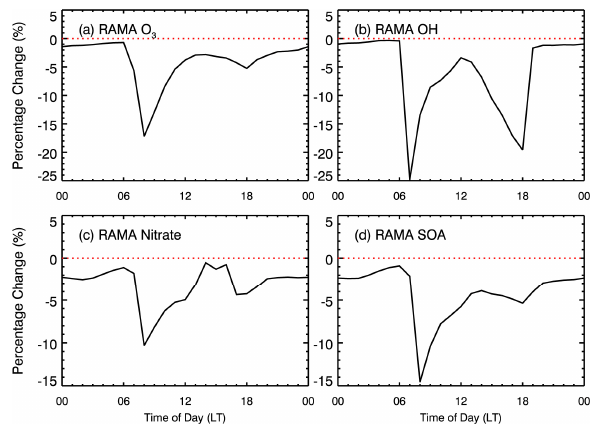
Figure 11 Fig. 11. Same as Fig. 10, but for the surface (a) O 3 , (b) OH, (c) Ni- trate, and (d) SOA concentrations.